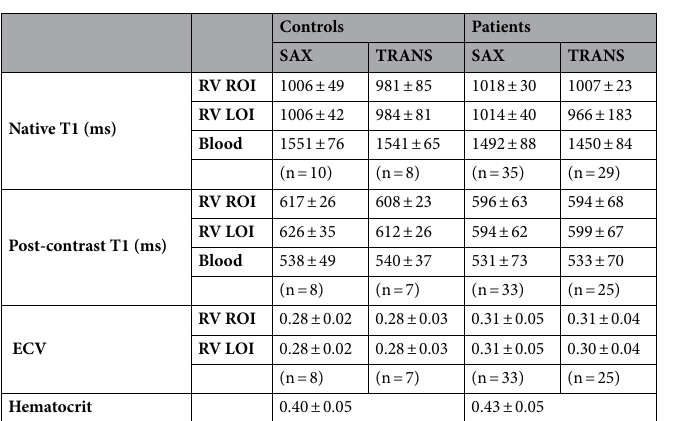
Table 4. Native T1, post-contrast T1 and extracellular volume of the right ventricle from regions of interest and corresponding lines of interest in short axis and transverse orientation. Values are given as mean ± standard deviation. ECV = extracellular volume; LOI = line of interest; ROI = region of interest; RV = right ventricle; SAX = short axis; TRANS = transverse.